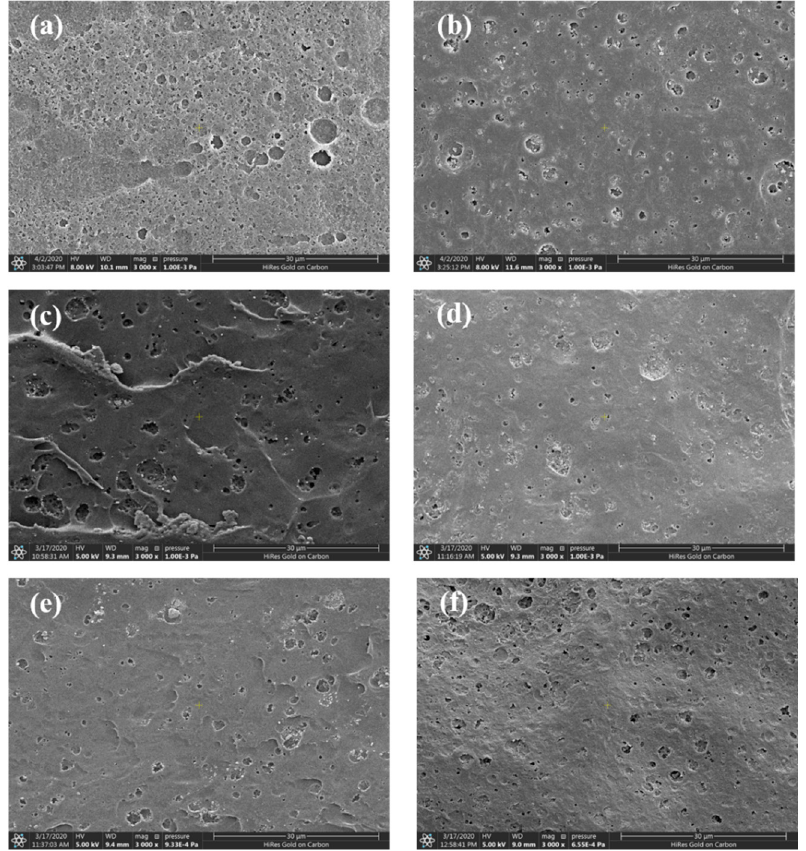
Figure 11. The SEM patterns of the resin surface after isothermal aging at 350 °C for 450 h: ( a ) control; ( b ) 0.2 wt% Nd 2 O 3 , ( c ) 0.4 wt% Nd 2 O 3 , ( d ) 0.6 wt% Nd 2 O 3 , ( e ) 0.8 wt%, and ( f ) 1 wt% Nd 2 O 3